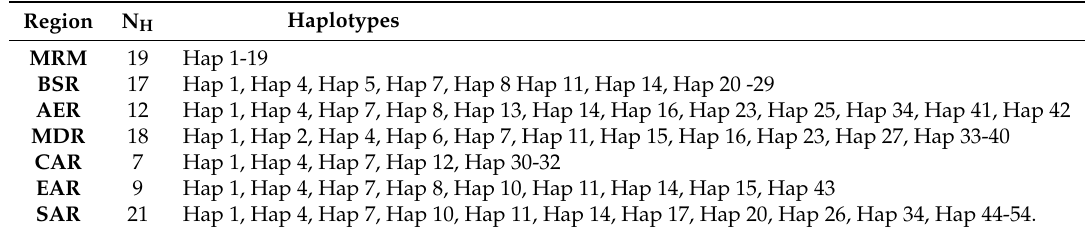
Table 3. The number of haplotypes observed by